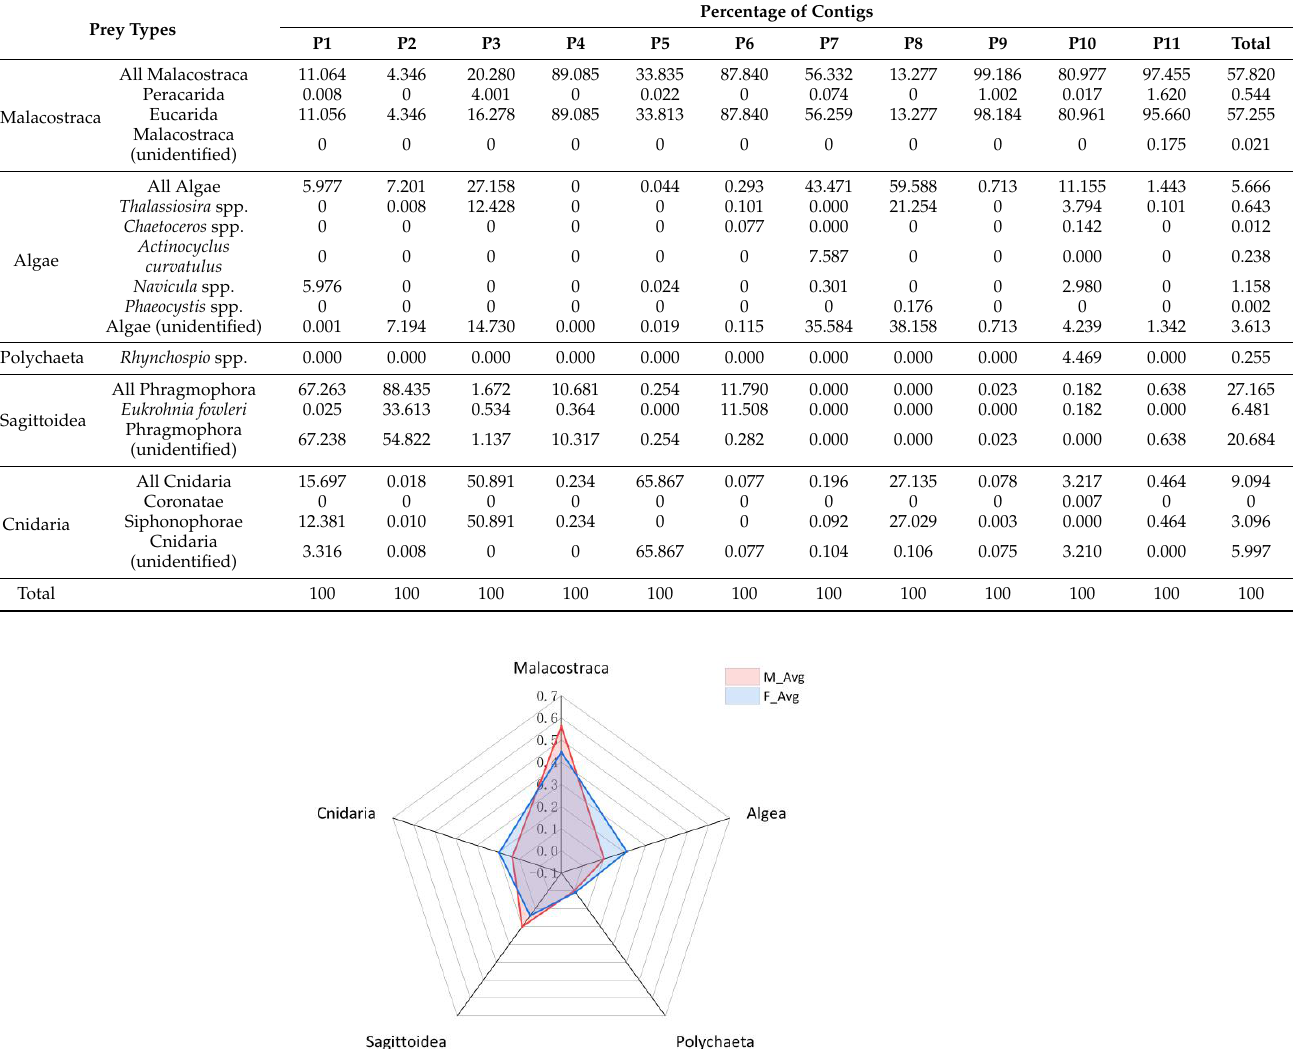
Table 5. List and proportions of prey items of M. caml as determined by NGS analysis. P1 to P11 refers to sample 1 to sample 11.